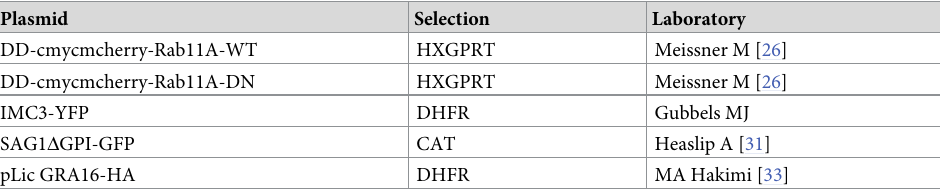
Table 1. List of plasmids used for parasite transfection. Plasmid